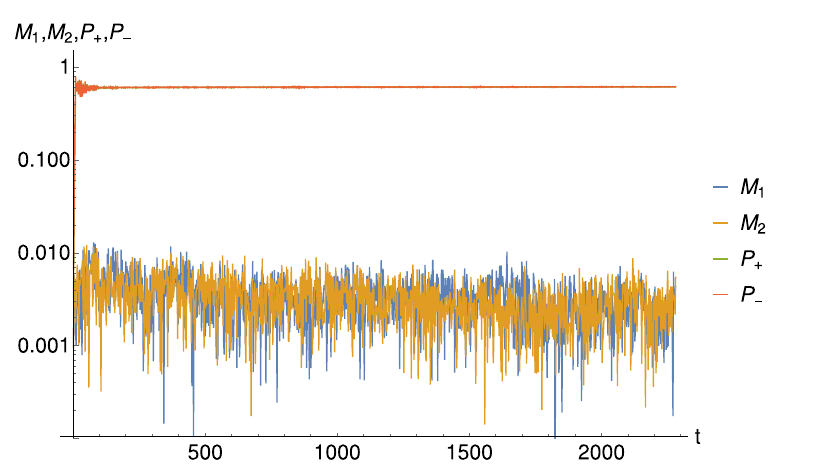
Figure 3. Time behaviour of the mean-fields moduli for the same parameters as in Fig. 2 in linear-log scale. The mean values for mean fields are N = 0.0035 and P ± =